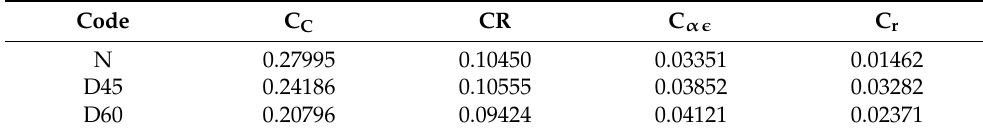
Table 5. Conducted and derived consolidation parameters for N, D45 and D60.